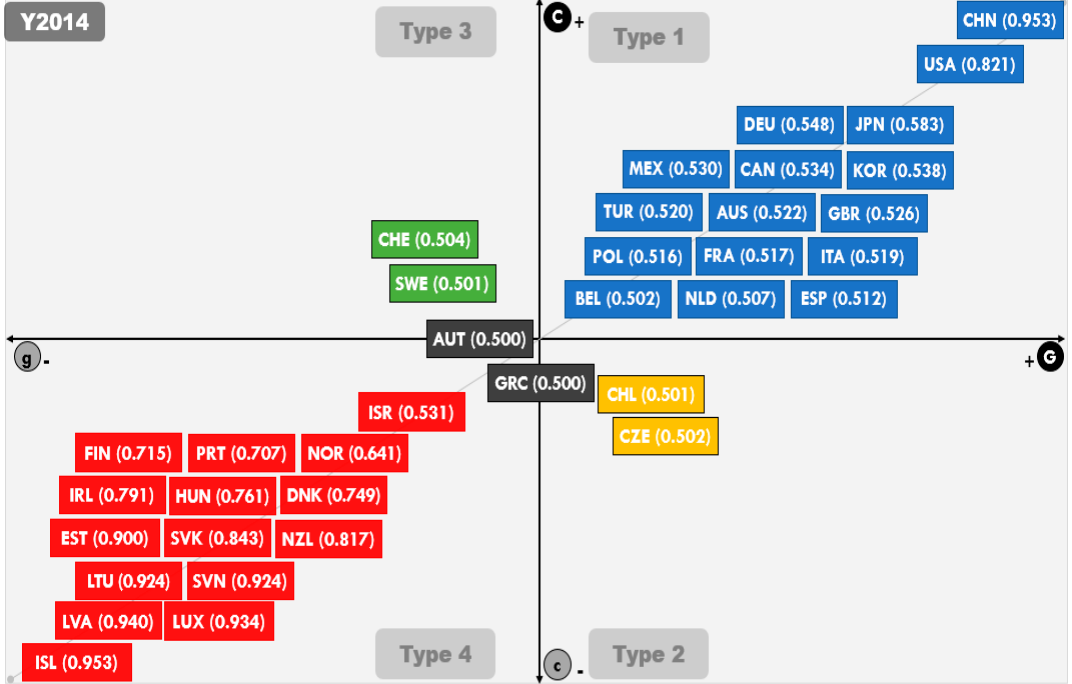
Figure 4. The Location of Link Types of the 37 Case Countries in 2014.